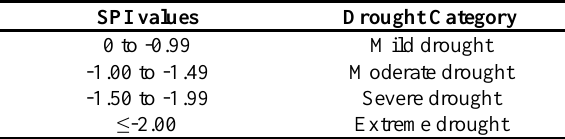
Table 2. SPI Drought